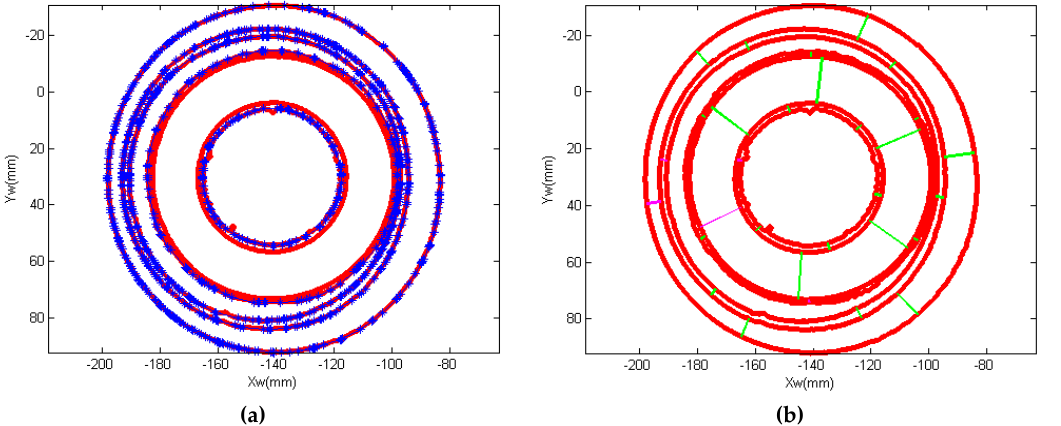
Figure 24. General view of cross-section measurement. ( a ) Perimeter measurement, in which red dots are extracted contour and blue asterisks are vertexes of contour convex hull; ( b ) Thickness measurement, in which magenta line denotes ( t i ) min and green lines are the other five measurements clockwise. Table 4. Measurement results of actual specimen cross-section. (unit: mm).